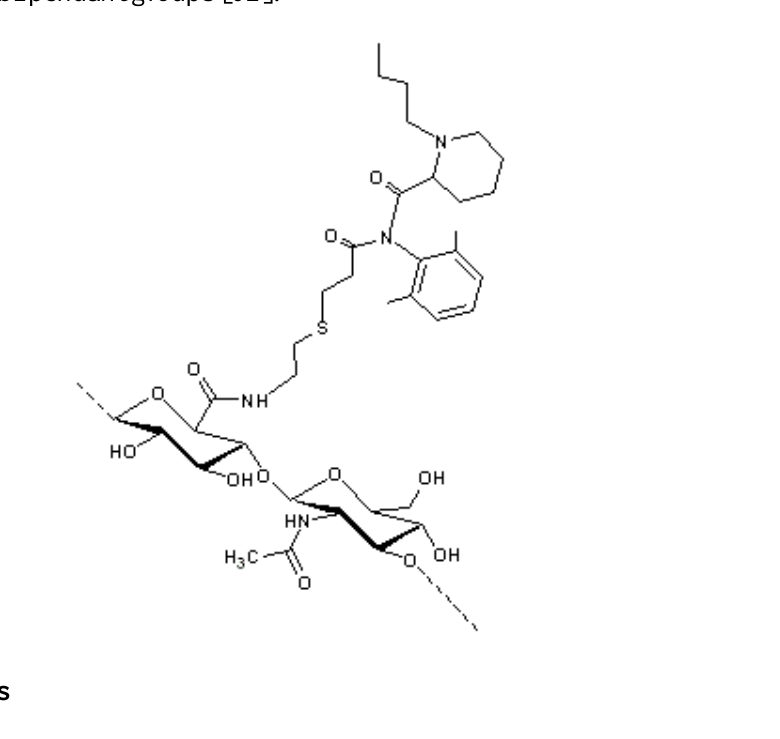
Figure 9. HA-Bupivacaine: an acrylated derivative of bupivacaine was linked to a modified HA with thiol pendant groups